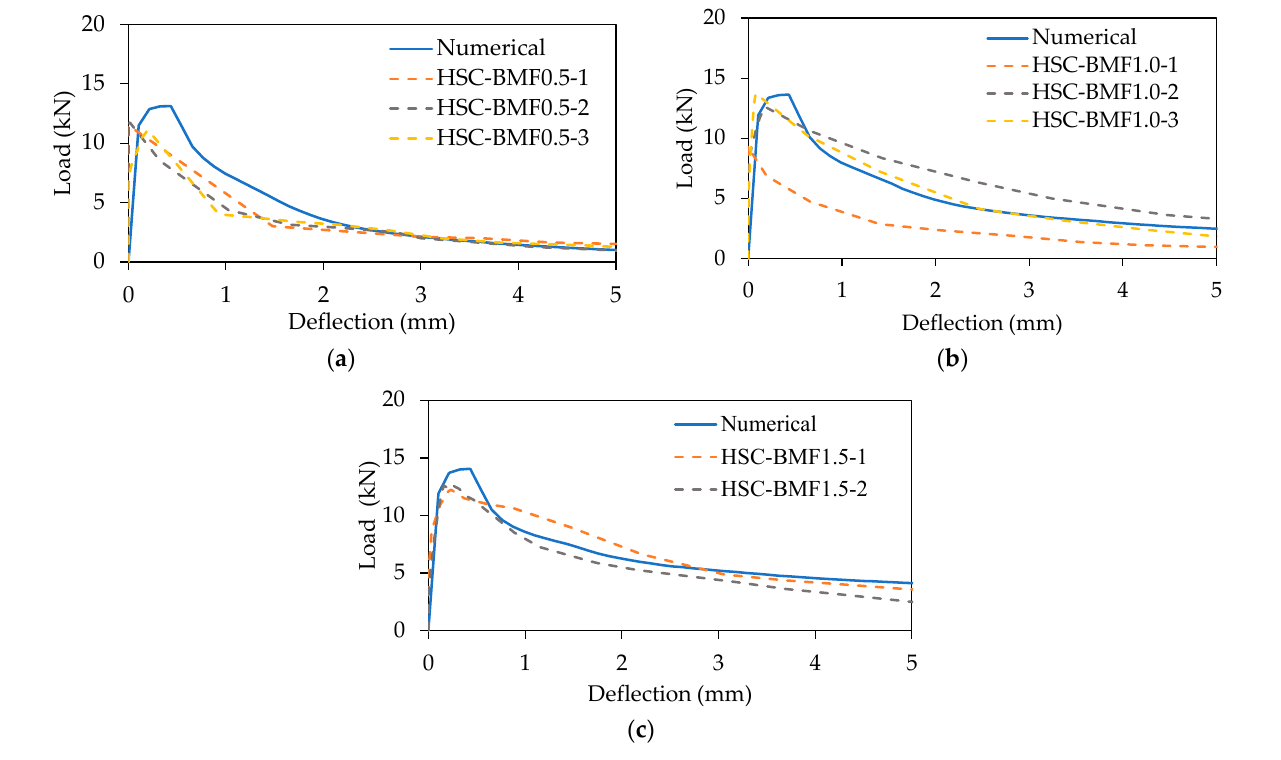
Figure 24. Numerical versus experimental flexural response of NSC: ( a ) ν f = 0.5%; ( b ) ν f = 1.0%; ( c ) ν f = 1.5%.